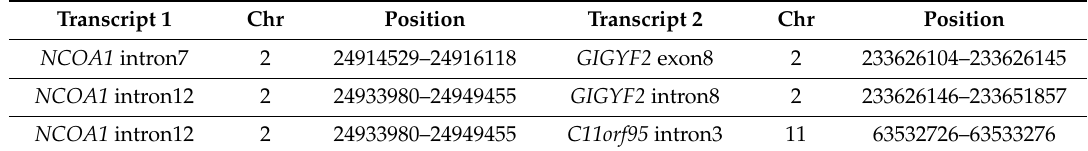
Table 3. Fusion transcripts detected by RNA